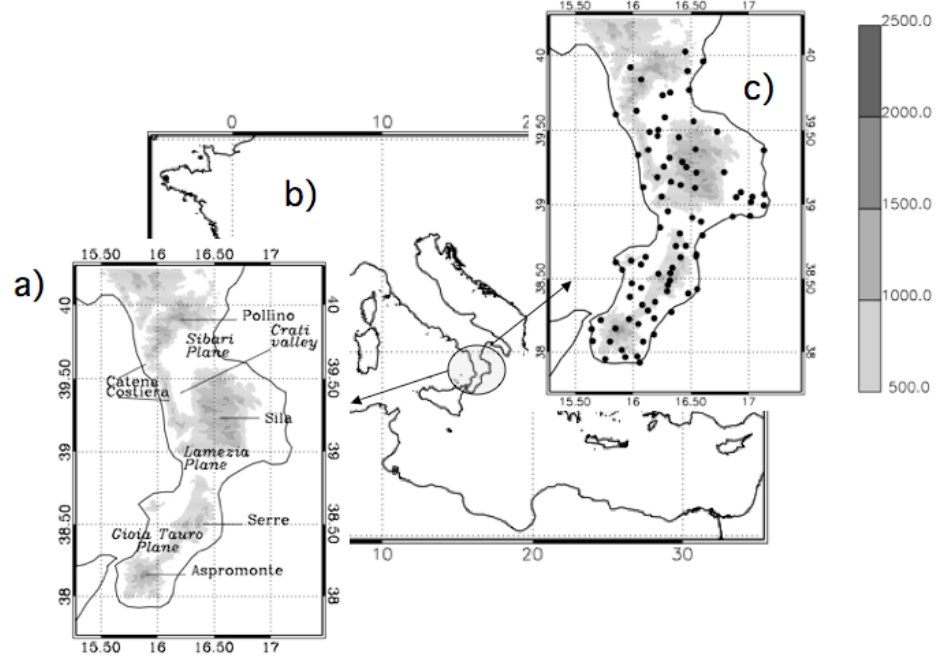
Fig. 1. (a) Calabria features cited into the text; (b) Calabria region and its position in the central Mediterranean; (c) Black-filled circles are the stations of the regional network. Grey shading shows the orographic height (m).